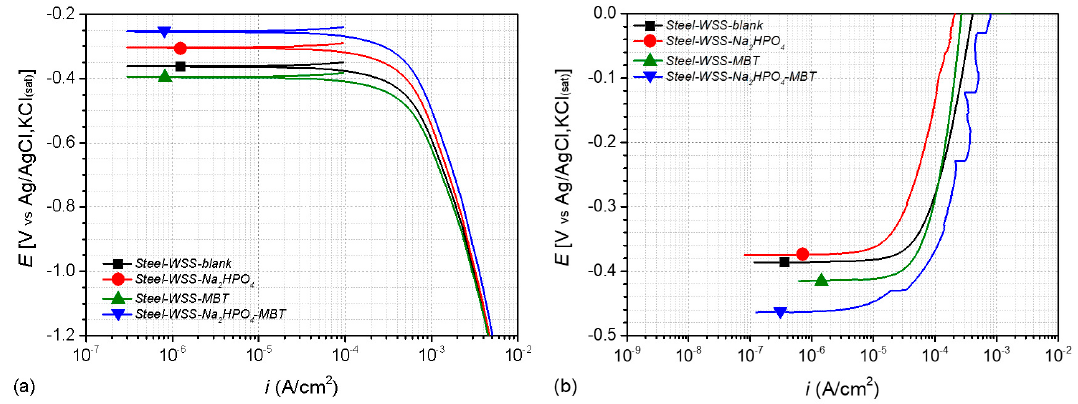
Figure 17. The polarization curves ( a ) cathodic, ( b ) anodic, recorded for mild steel panels after submission in WSS for 24 h: ( (cid:4) filled square ) Steel–WSS–blank , ( (cid:8) filled circle ) Steel–WSS–Na 2 HPO 4 , ( (cid:78) filled triangleD ) Steel–WSS–MBT , ( (cid:72) filled triangleU ) Steel–WSS–Na 2 HPO 4 –MBT .